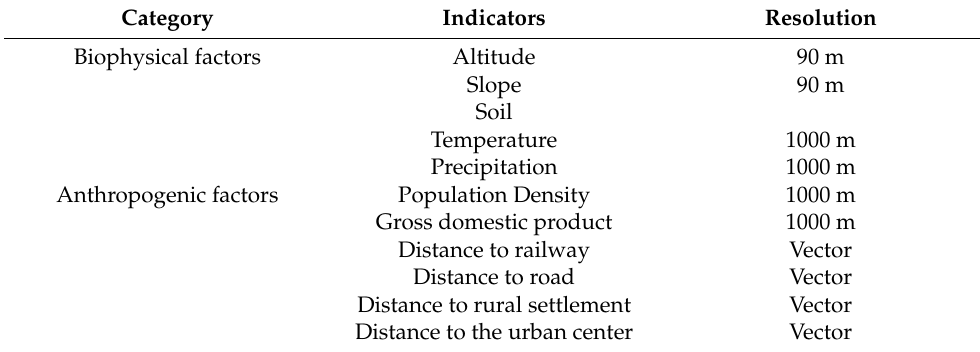
Table 2. The selected factors of land use